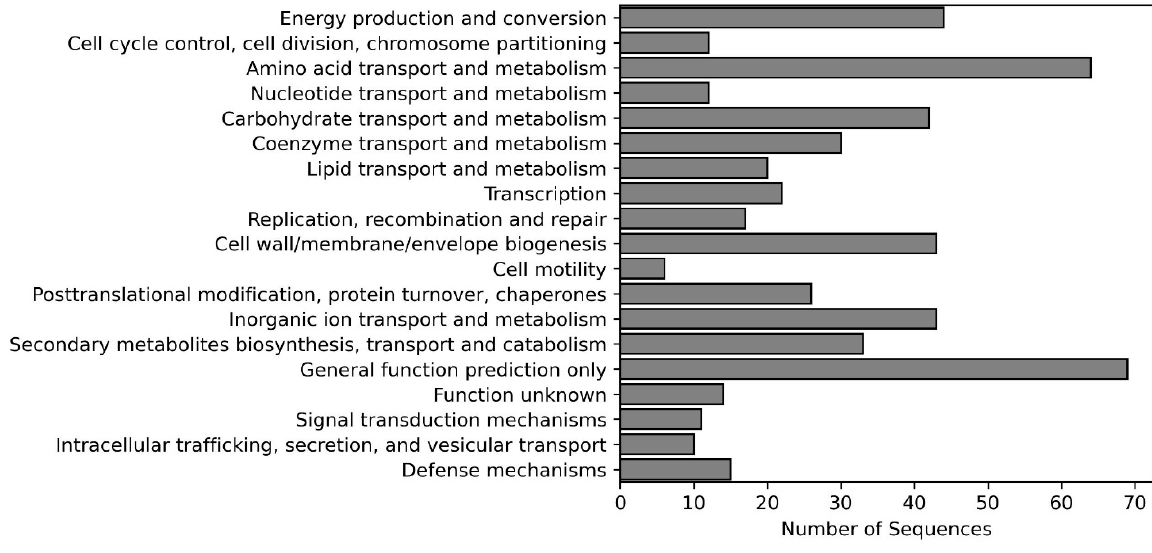
Figure 4. Functional analysis of upregulated genes after mapping to the database with cluster of orthologous groups (COGs).